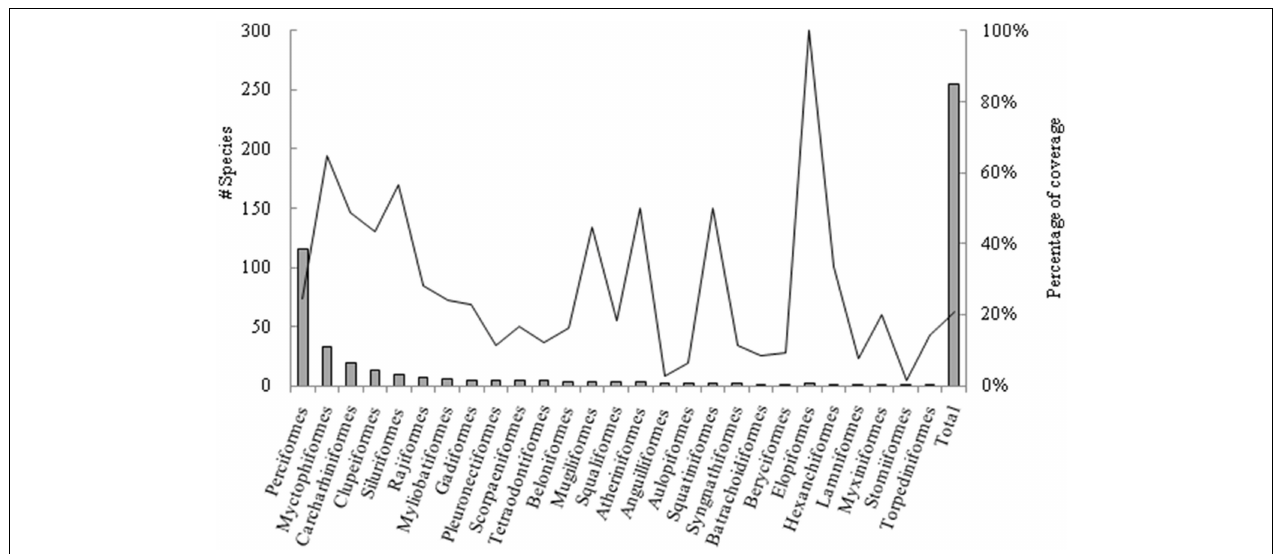
FIGURE 4 | Number of marine fish species studied in terms of reproduction in Brazil per order (columns) and percentage of the number of species studied in relation the total number of species within each order (line).